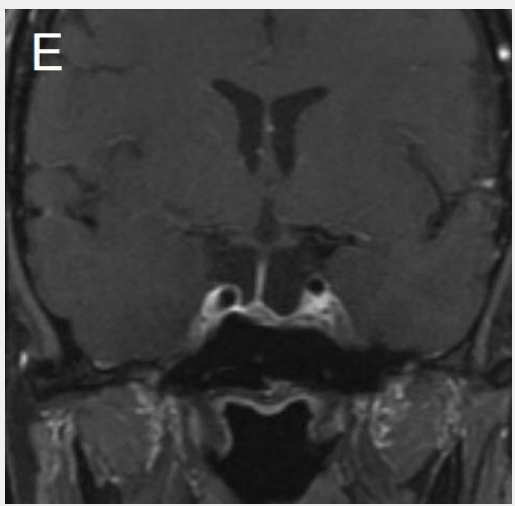
Illustrative case: Preoperative, intraoperative and postoperative imaging. A: Preoperative MRI, coronal view, contrast enhanced. B: Intraoperative MRI, coronal view, contrast enhanced, before skin incision. C: Intraoperative MRI, coronal view, contrast enhanced, during resection. D: Intraoperative MRI, coronal view, contrast enhanced, before closure. E: Postoperative MRI, coronal view, contrast